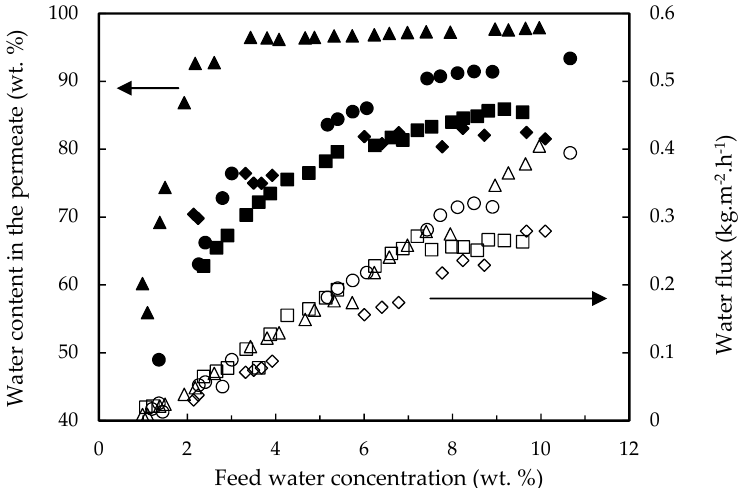
Figure 4. Water permeation fluxes (open symbols) and water concentration in permeate (closed symbols) as a function of feed water content for four mixtures: ( , ) 13.5% lactic acid, 17.7% ethyl lactate, 10% water and 58.8% ethanol; ( , ) 17.7% ethyl lactate, 10% water and 72.3% ethanol; ( , ) 13.5% lactic acid, 10% water and 76.5% ethanol; ( , ) 10% water and 90% ethanol. PERVAP™ 1131 membrane at T = 60°C.